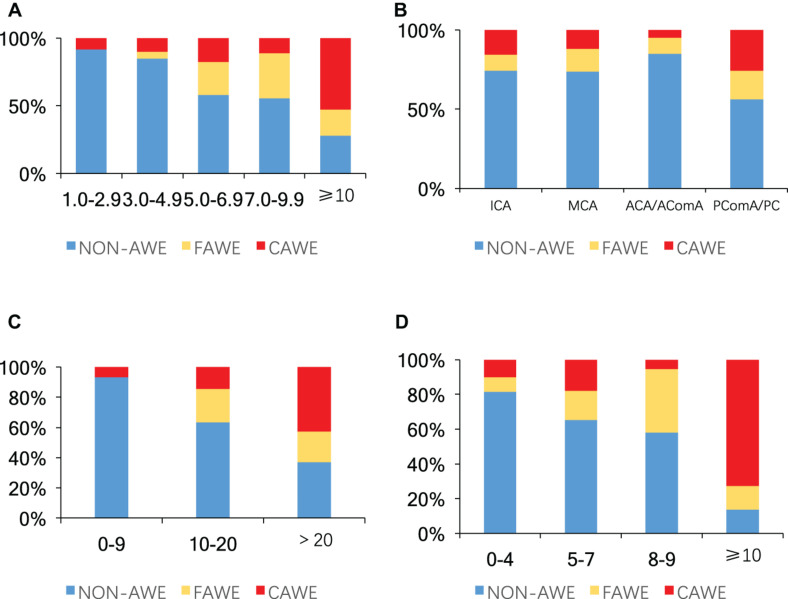
Proportions of aneurysms without enhancement, focal enhancement, and circumferential enhancement according to: (A) aneurysm size (mm), (B) location, (C) ELAPSS score, and (D) PHASES score (P < 0.001, P = 0.013, P < 0.001, and P < 0.001, respectively). Blue, non-aneurysm wall enhancement; yellow, focal aneurysm wall enhancement (FAWE); red, circumferential aneurysm wall enhancement (CAWE); AWE, aneurysm wall enhancement; ICA, internal carotid artery; MCA, middle cerebral artery; ACA, anterior cerebral artery; AComA, anterior communicating artery; PComA, posterior communicating artery; PC, posterior circulation.